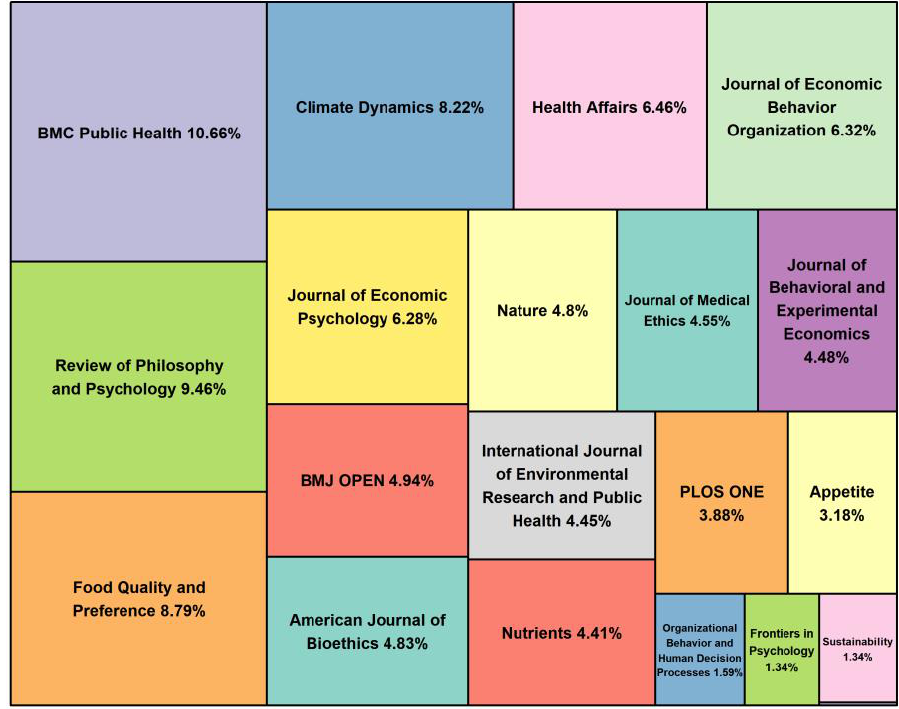
Figure 3. Treemap of the top 20 journals with average citations.